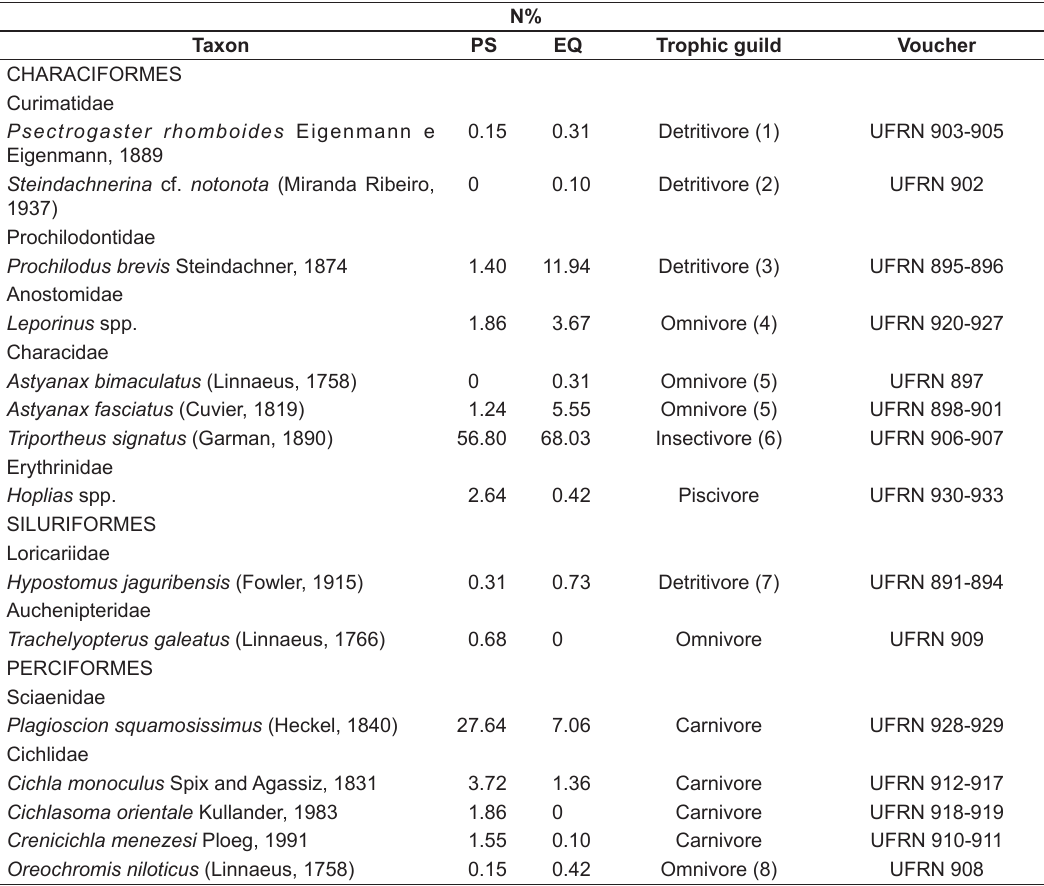
Table 2. Fish species collected in the Paulo Sarasate (PS) and Edson Queiroz (EQ) reservoirs, with their relative abundance (N%) and trophic guilds. Trophic guilds of non-predatory species were obtained from the studies on the species or congeners: (1) Mérona & Rankin-de-Mérona (2004), (2) Montenegro et al. (2011), (3) Castro & Vari (2004), (4) Montenegro et al. (2010), (5) Gurgel et al. (2005), (6) Pinto et al. (2011), (7) Mazzoni et al. (2010), (8) Silva (2009).